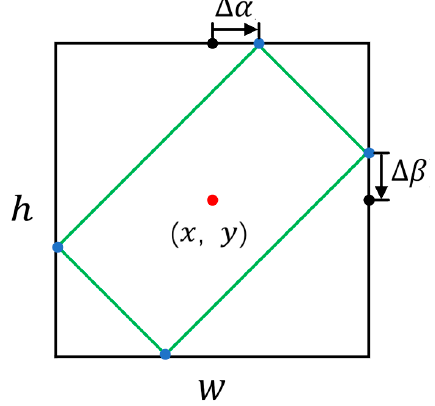
Figure 3. The illustration of box-regression parameterization.